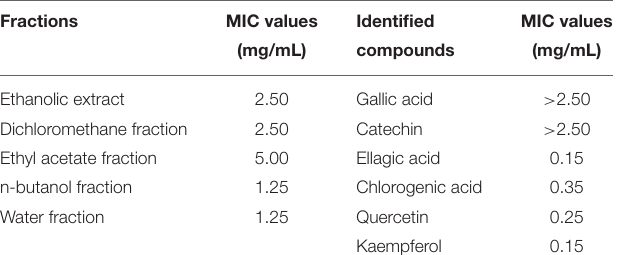
TABLE 1 | Minimum inhibitory concentrations (MICs) of the five fractions and six compounds identified from Camellia nitidissima Chi flowers against Pseudomonas aeruginosa PAO1.